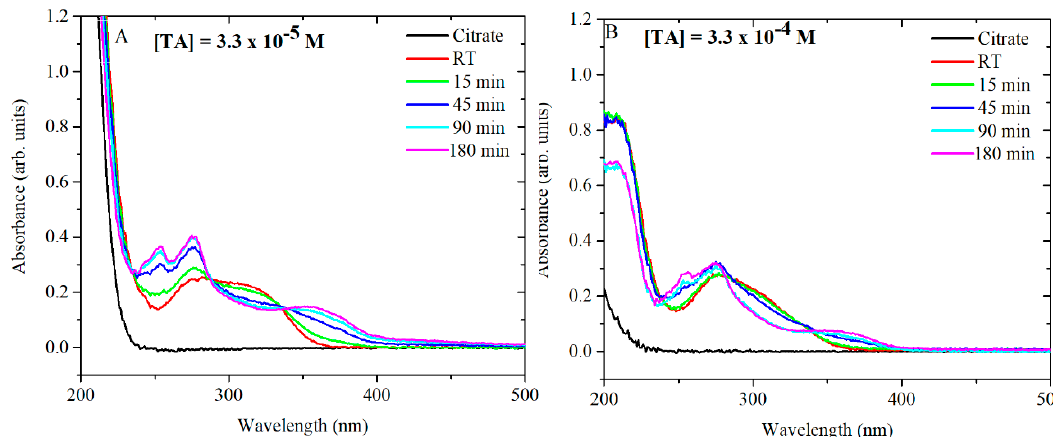
Figure 7. UV-vis spectra of TA thermally preconditioned at 60 °C for various times in 21 mM citrate: ( A ) TA 3.3 × 10 − 5 M and ( B ) TA 3.3 × 10 − 4 M. For the purpose of comparison, the spectra were obtained from thermal conditioned samples which, immediately prior to UV-vis analysis, were diluted in water to obtain a TA concentration of 4 × 10 − 6 M. In the UV measurements, the concentration of citrate is 2.5 mM in ( A and 0.25 mM in B ).